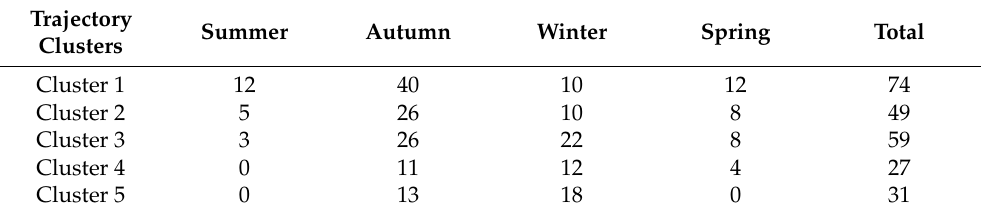
Table 2. Number of 120 h back trajectories in five clusters as shown in Figure 2.